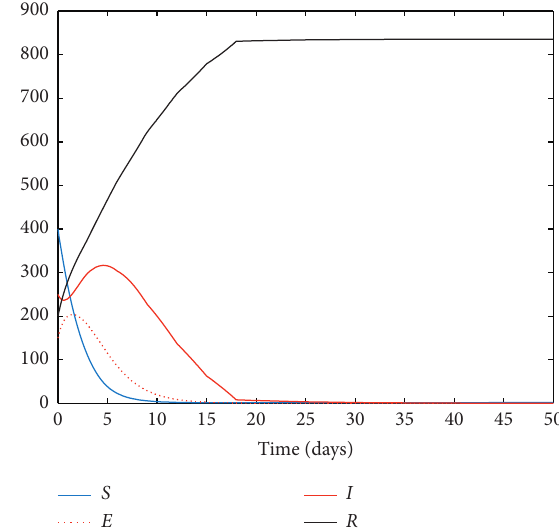
Figure 11: Evolution of the system when Δ t � 12 hours and n � 20 days.